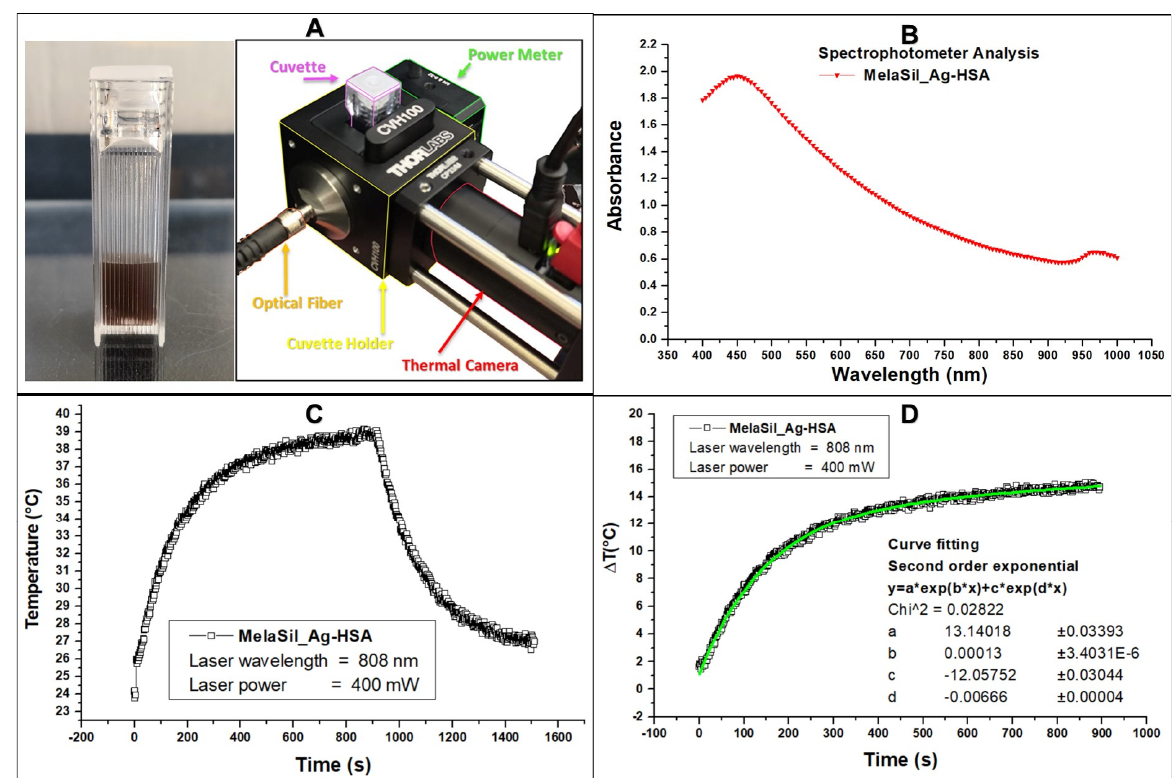
Figure 6. Thermal properties of MelaSil_Ag − HSA NPs. ( A ) MelaSil_Ag − HSA nanoparticles (1 µg/µL); ( B ) spectrophotometric analysis of the light absorbance properties of MelaSil_Ag − HSA; ( C ) typical thermal trends of MelaSil_Ag-HSA, CW heating (laser on), and cooling (laser off) processes; ( D ) dynamic evaluation of heating performances of MelaSil_Ag − HSA during laser illumination, and the fitting curve (green) of Δ T vs. time.